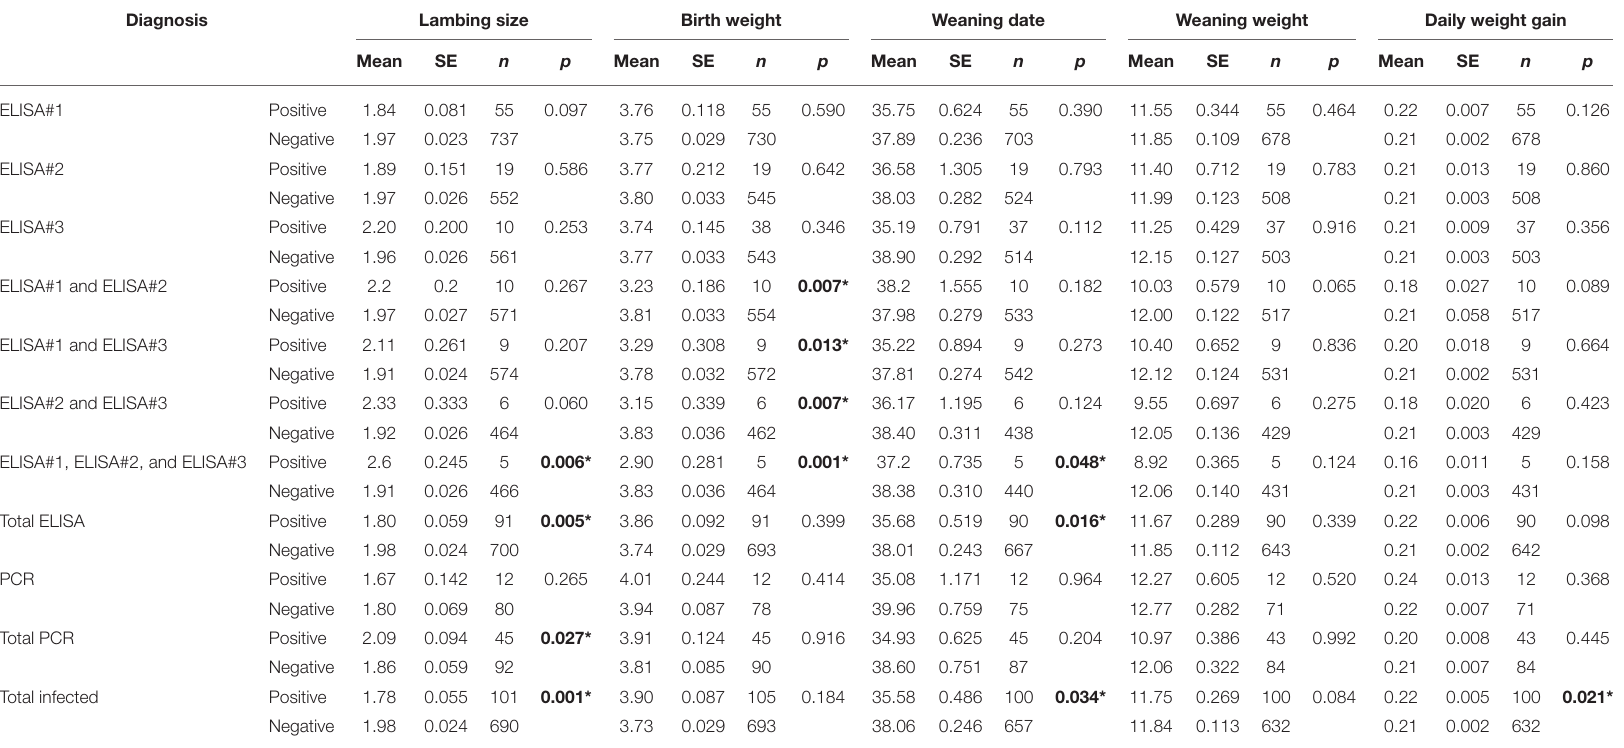
TABLE 4 | Meat production parameters in Flocks A and B of the Raza Navarra breed according to SRLV infection